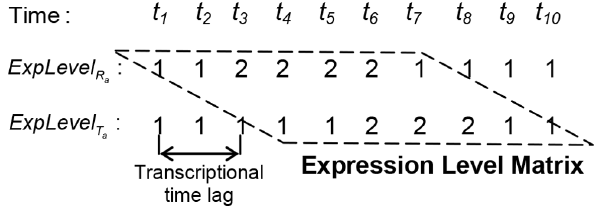
Figure 3. Construction of expression level matrix. As is shown in Figure 2, the transcriptional time lag between R a and T a is 3 time unit . After discretizing the expression of the gene pair, we organize ExpLevel R and ExpLevel T into the expression level matrix, where a a the expression level of R a at time point t i is aligned with the expression level of T a at time point t i z 3 time unit .